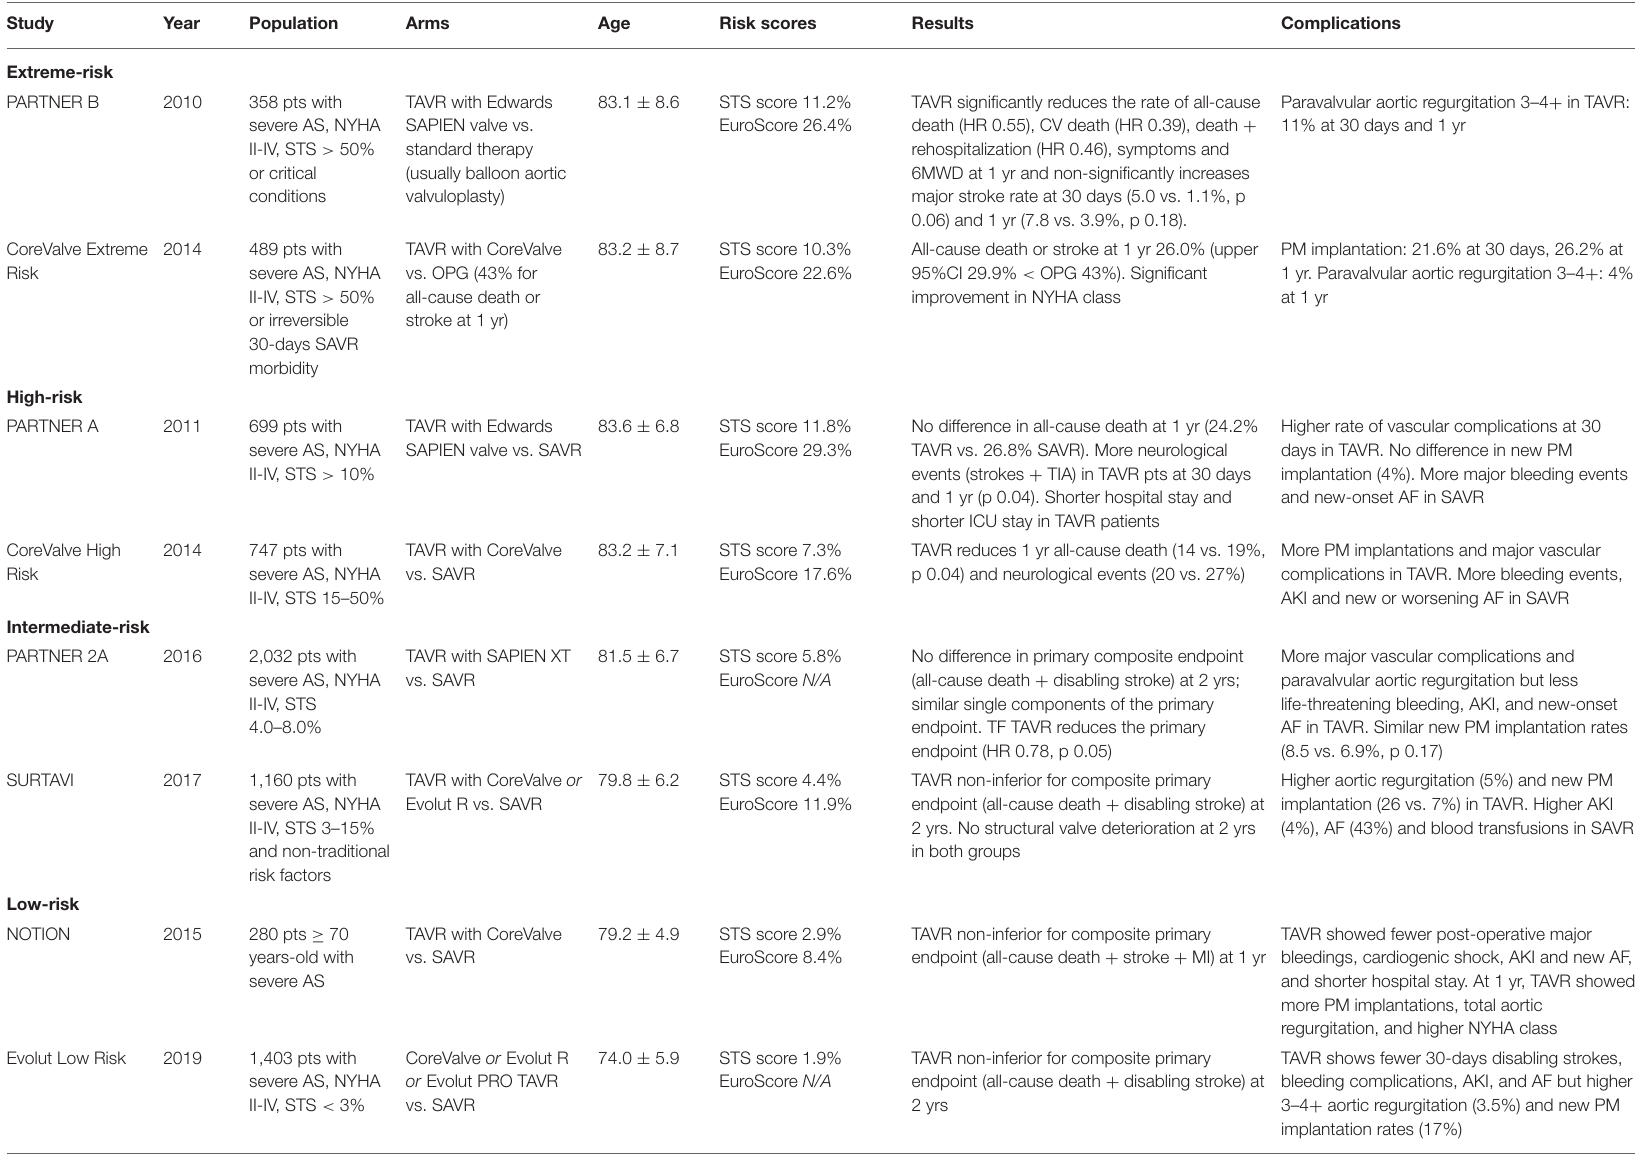
TABLE 1 | Characteristics of the landmark studies on transcatheter aortic valve